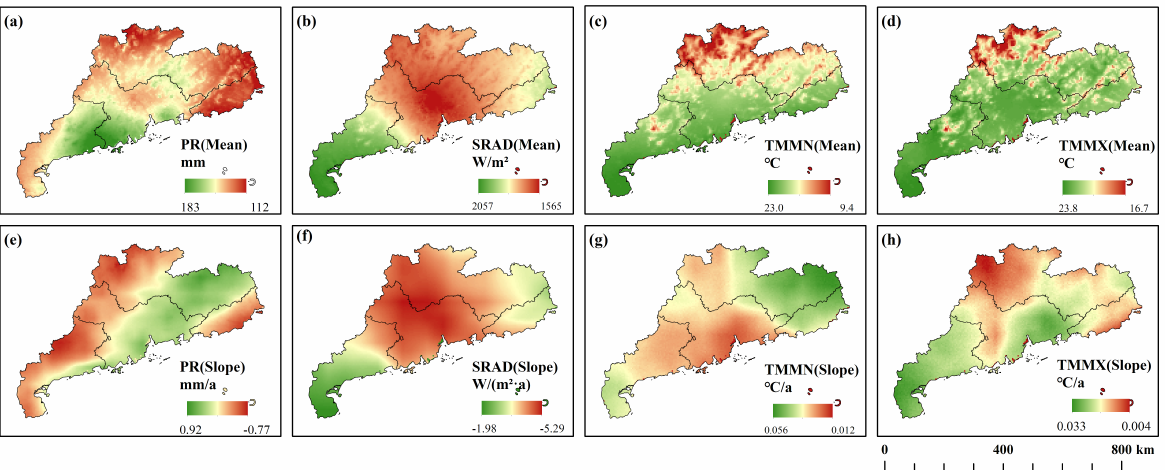
Figure 4. Twenty-year averages ( a – d ) and annual mean change rates ( e – h ) of precipitation, downgra- dient shortwave radiation, monthly minimum temperature, and monthly maximum temperature in southern China.